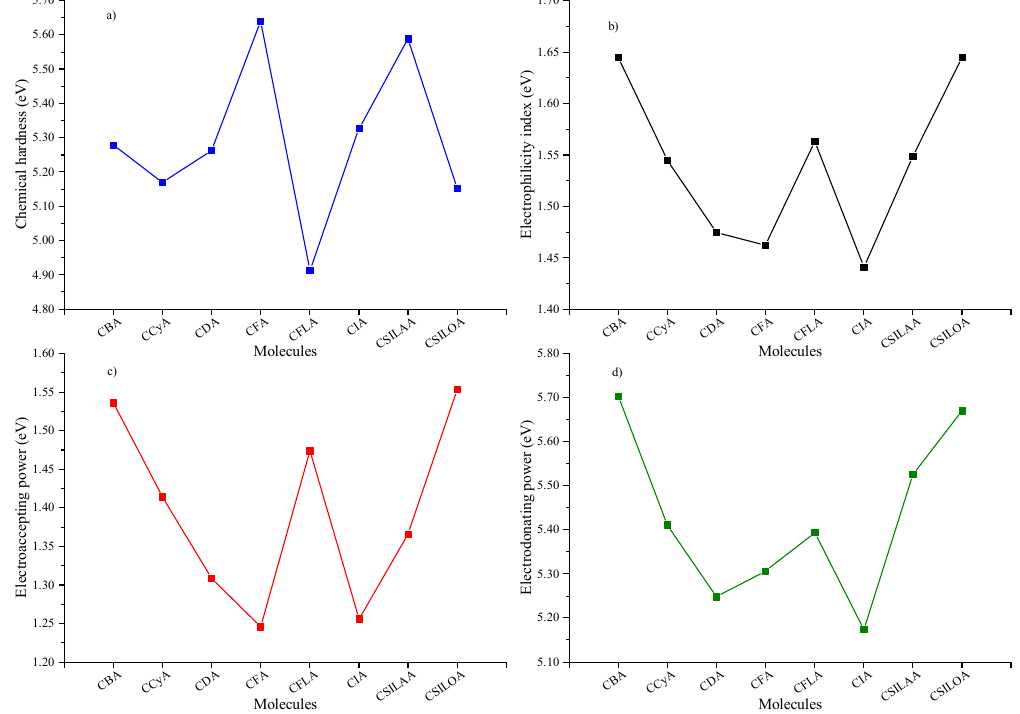
Figure 5. ( a ) Chemical hardness, ( b ) electrophilicity index, ( c ) electroaccepting power, and ( d ) electrodonating power of the molecular systems.